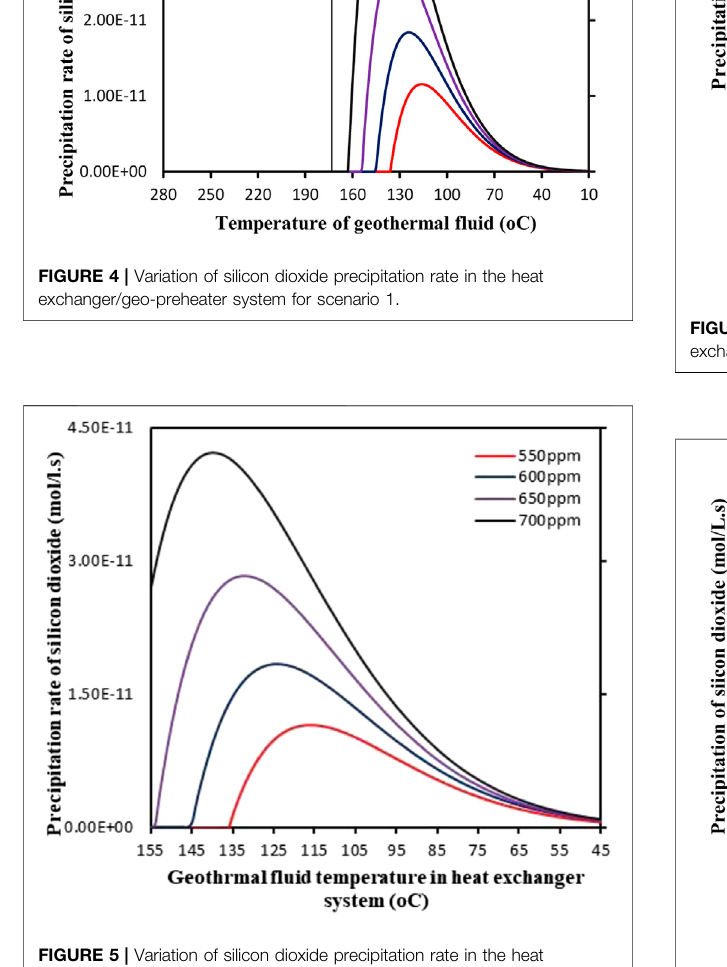
FIGURE 7 | Precipitation rate as a function of temperature in the heat exchanger system for Scenario